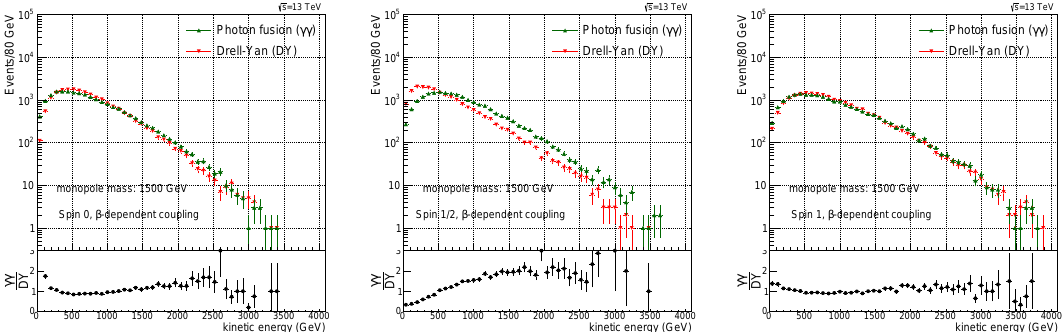
Figure 4. Kinetic energy distribution comparison between the photon fusion and Drell–Yan processes for spin 0 ( left ), spin 1 / 2 ( middle ), and spin 1 ( right ) monopoles. Here, β -dependent coupling has been used. For the PDFs, NNPDF23 was used for the Drell–Yan process and LUXqed was used for the photon fusion process